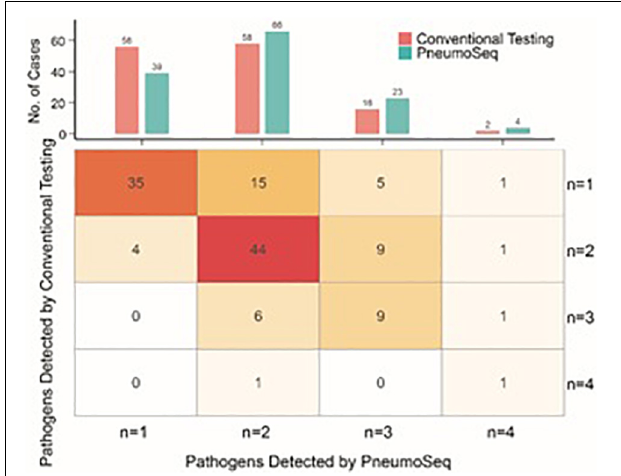
FIGURE 5 | Comparison between conventional testing and PneumoSeq for detecting potential polymicrobial infections. Upper panel, cases with various numbers of potential pathogens detected; Lower panel, expanded table showing the detailed case